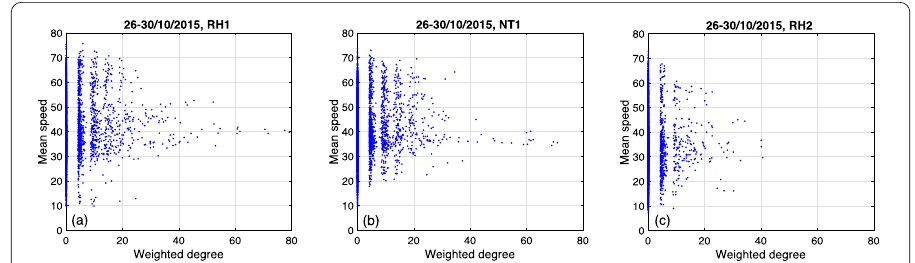
Figure 8 Relation between the mean road speed in the different time periods and weighted degrees. ( a ) Mean road speed (in km · h –1 ) over the time period VS weighted degree during RH1. Pearson’s correlation: 0.0950. ( b ), ( c ) The same as ( a ) but during NT1 and RH2. Pearson’s correlations: 0.0878 and 0.0182. The data is during 26–30 Oct. 2015, N = 4530, L = 900, and τ max =